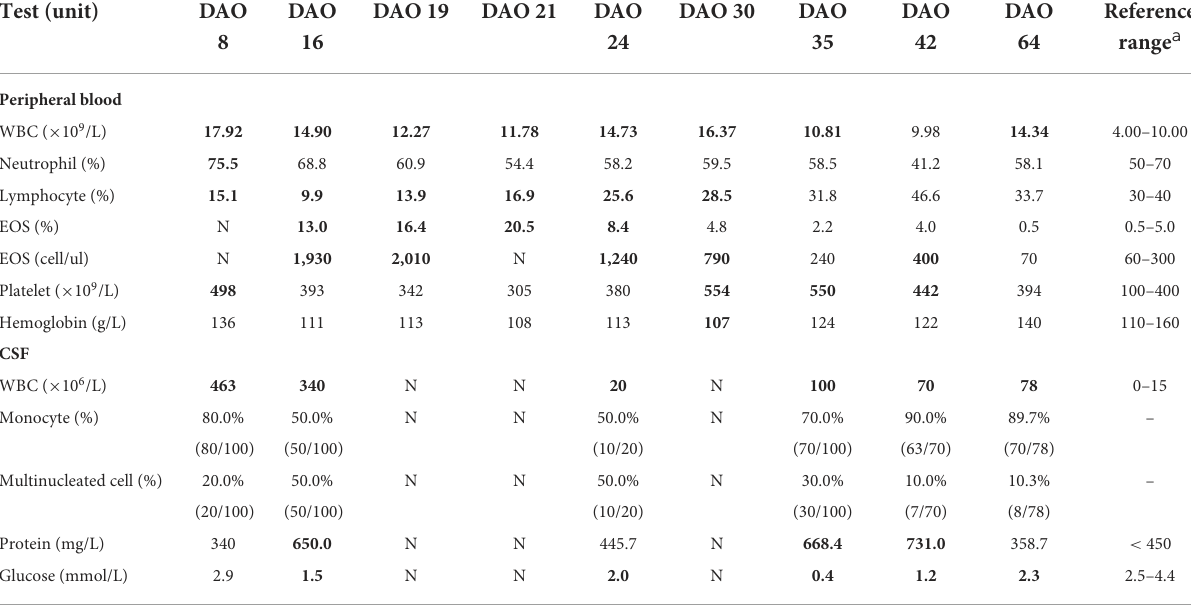
TABLE 1 Laboratory test results of peripheral blood and cerebrospinal fluid during